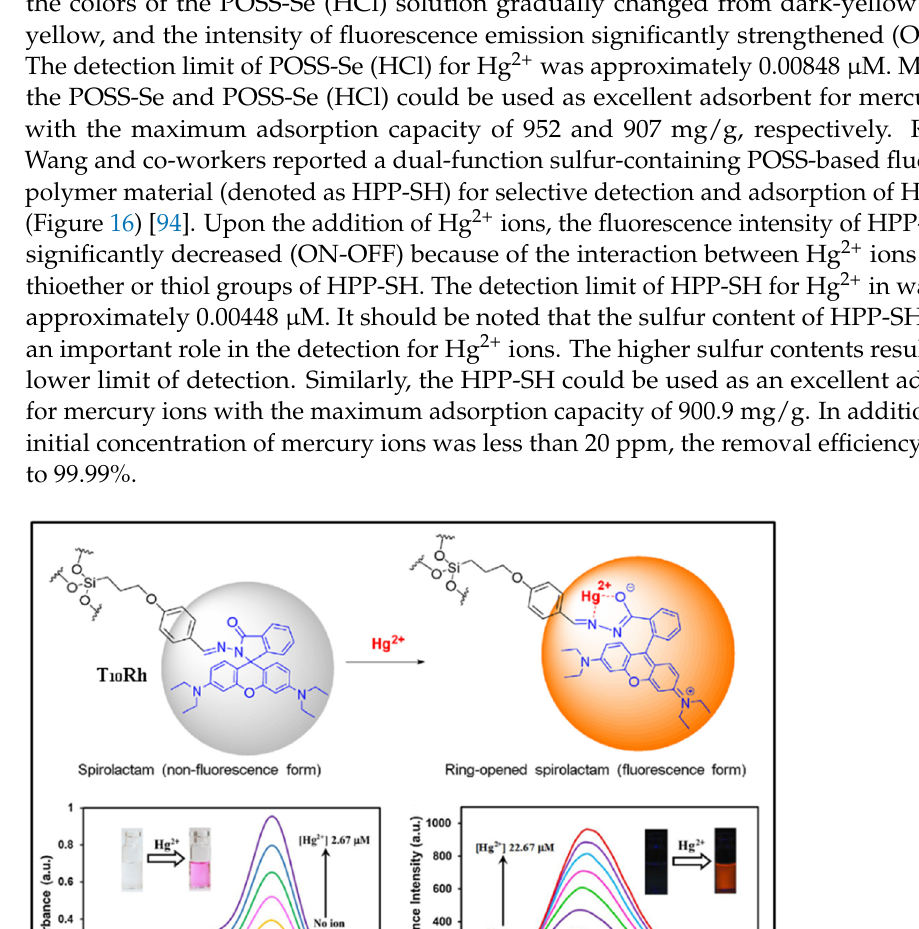
Figure 16. ( a ) Molecular structures of HPP-SH [94]; ( b ) the PL spectra of the HPP-SH suspension (0.1 mg/mL) in 50% aqueous ethanol in the presence and absence of Hg 2+ (100 ppm) [94]; ( c ) selec- tivity of the HPP-SH suspension (0.1 mg/mL) for Hg 2+ [94]; ( d ) the removal efficiency of HPP-SH suspension (1 mg/mL) for Hg 2+ in the presence of various metal ions (50 ppm) [94].